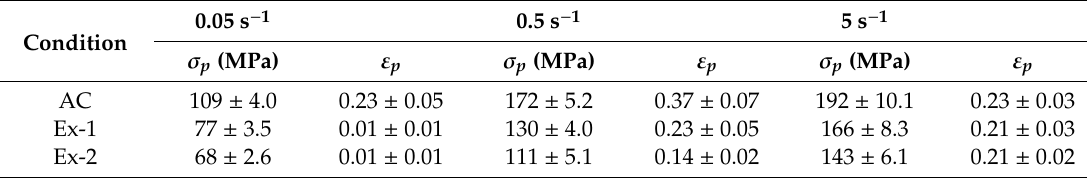
Table 2. Comparison of the peak stress ( σ p ) and strain ( ε p ) achieved by the AC, Ex-1 and Ex-2 specimens when compressed at 400 ◦ C and various strain rates of 0.05, 0.5, and 5 s − 1 . 0.05 s − Condition